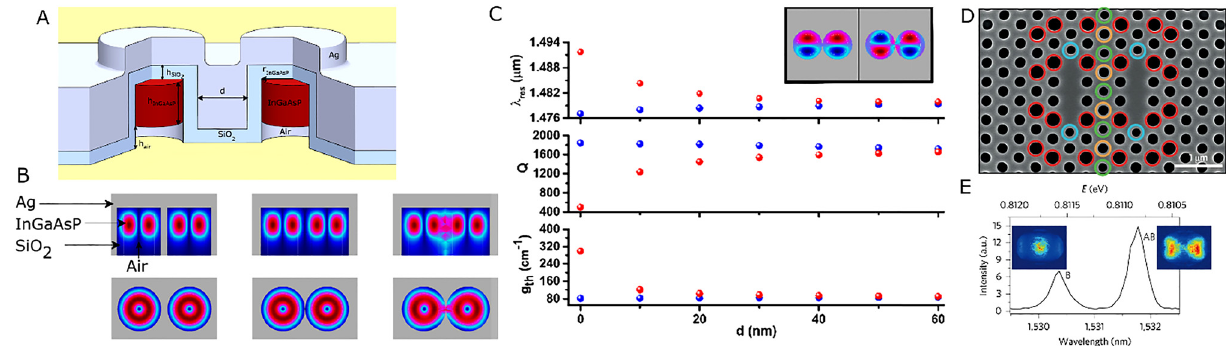
Figure 1: Supermode creation in dual nanolaser systems. (A) Two coupled metallo-dielectric nanolasers, where the distance between cavities is represented by d . (B) Electric fi eld intensity pro fi les acrosstheside(toprow)andtop(bottomrow)crosssectionsofthenanolasersystemshownin(A).When d =90nm(left),systemsupportstwo identical and independent TE 011 modes. When d = 0 nm, two new modes are supported by the system – antibonding (middle) and bonding supermodes (right). (C) Eigenmode wavelengths ( λ ), quality factors ( Q ), and gain thresholds ( g th ) for the two modes supported by the dual nanolaser system at varying d . Inset: electric fi eld distributions of the antibonding (left) and bonding (right) supermodes. (A), (B) and (C) reprinted from a study by Deka et al. [35] with permission. (D) Two coupled photonic crystal nanolasers and (E) the bonding (B, left peak) and antibonding (AB, right peak) modes supported in this design. (D) and (E) adapted and reprinted from a study by Hamel et al. [36] with